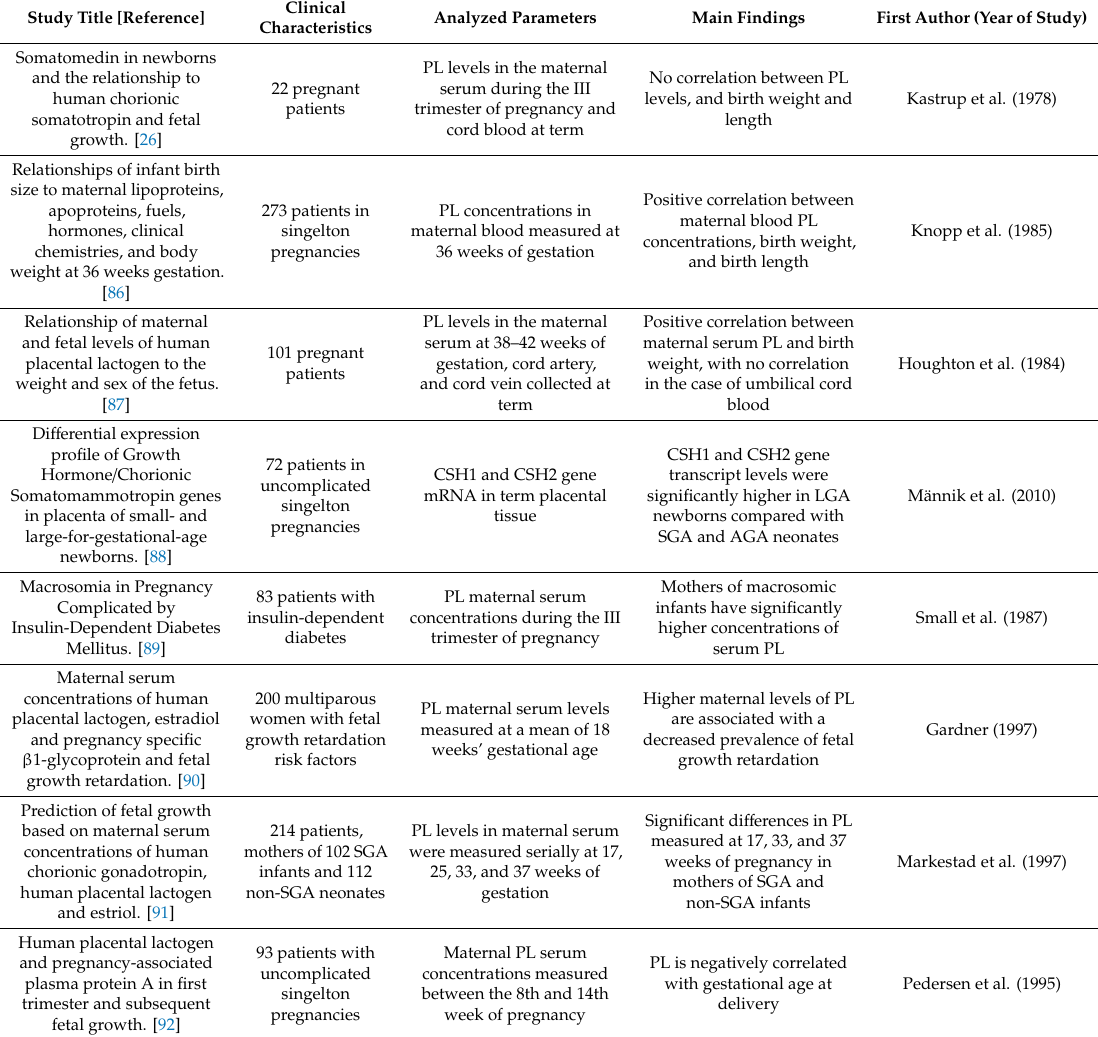
Table 2. Placental lactogen in the regulation of fetal